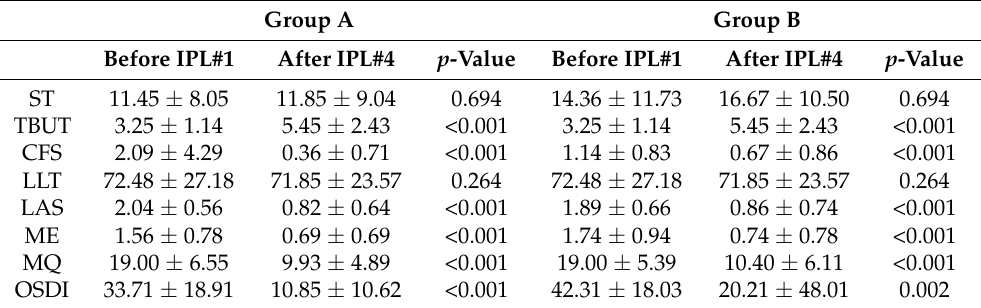
Table 2. Results of changes in DE and MGD parameters obtained before and after intense pulsed-light treatment in Groups A and